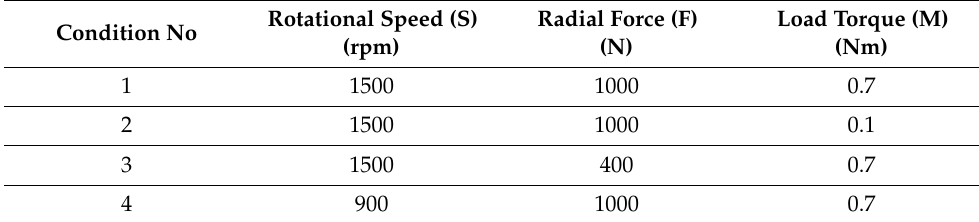
Table 1. Operating conditions of the testbed.